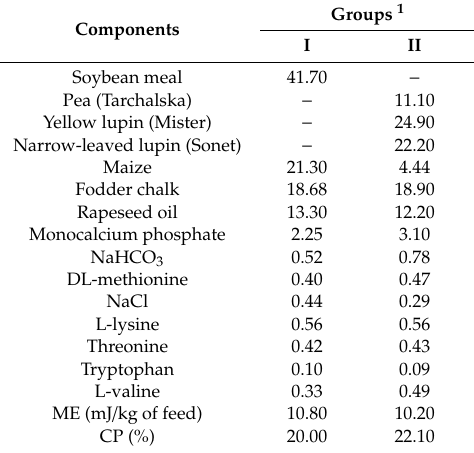
Table 3. Component contents in concentrates